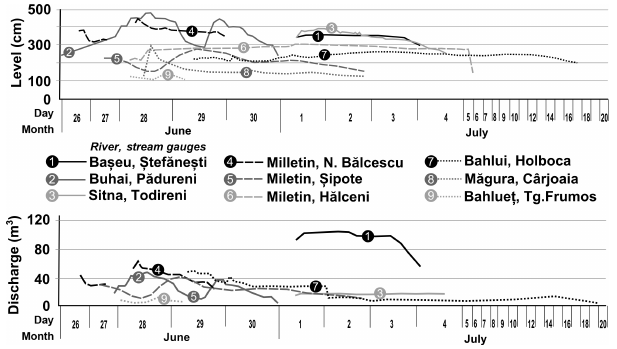
Figure 7. Water levels and discharge on the main Prut tributaries during the summer of 2010: the Baseu, Buhai, Sitna, Miletin, Bahlui, Magura, and Bahluiet